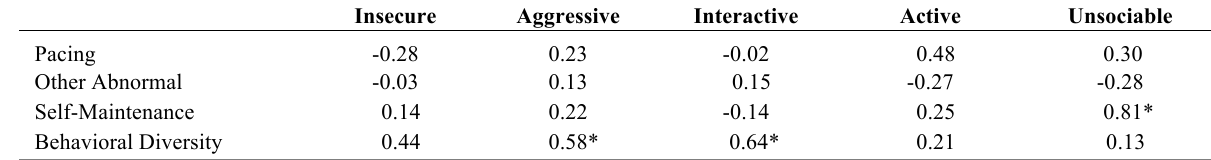
Spearman’s Rho Correlation Coefficients of Personality Components Compared to Indicators of